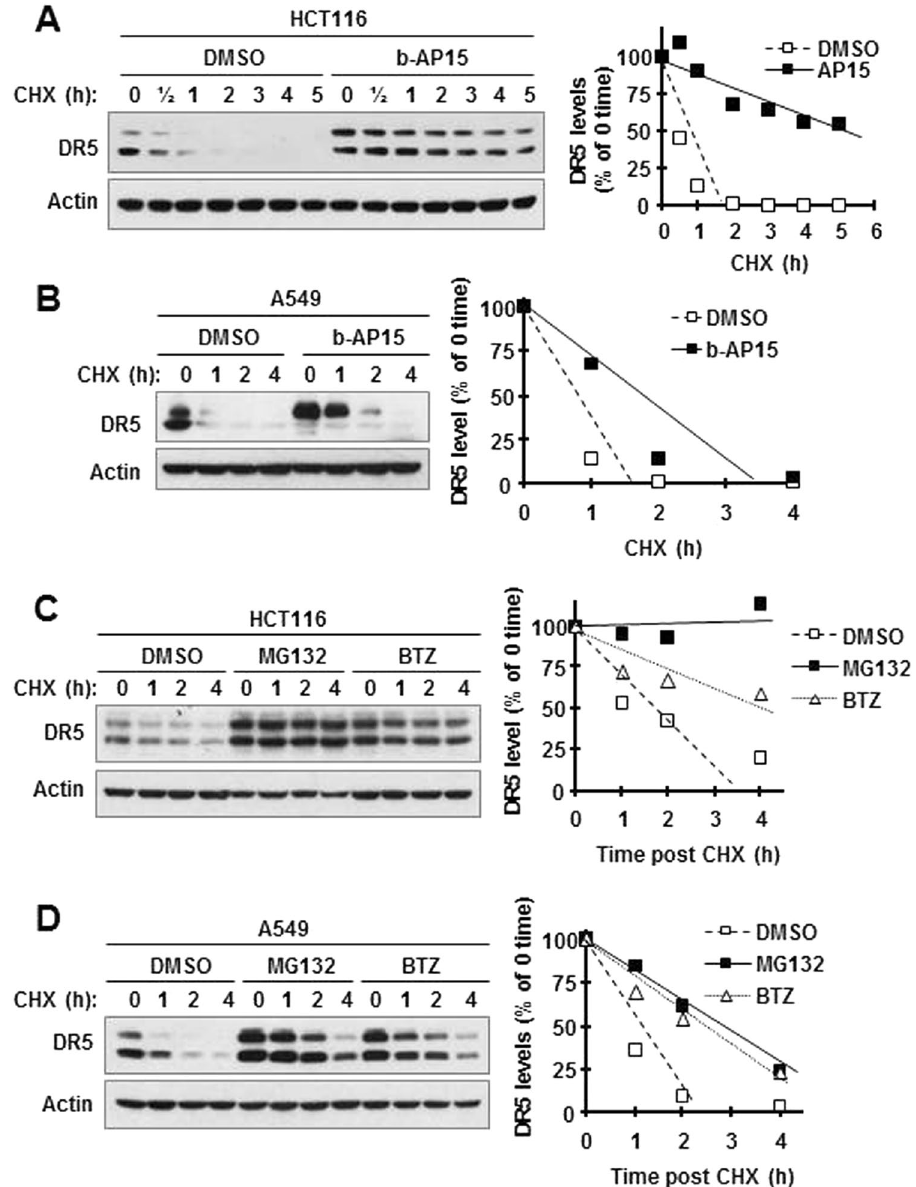
Figure 2. b-AP15 ( A and B ) and proteasome inhibitors ( C and D ) suppress DR5 degradation. Then indicated cancer cell lines were treated with DMSO or 0.5 μ M b-AP15 for 8 h ( A and B ) or with DMSO, 10 μ M MG132 or 100 nM BTZ for 5 h ( C and D ) followed by the addition of 10 μ g/ml CHX. At different times as indicated post CHX, the cells were harvested for preparation of whole-cell protein lysates and subsequent Western blotting. Protein levels were quantified with NIH Image J software (Bethesda, MA) and were normalized to actin. The results were plotted as the relative DR5 levels compared to those at the time 0 of CHX treatment (right panel). Full-length blots/gels are presented in Supplementary Figure